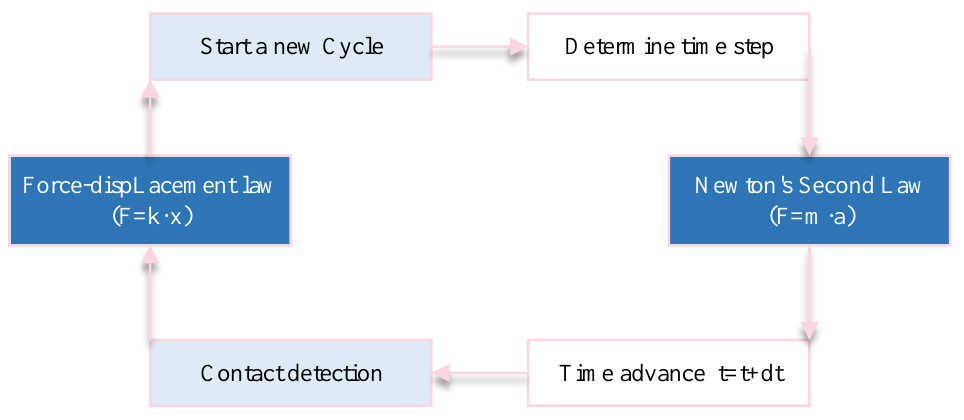
Figure 2. The basic cycle process of PFC.